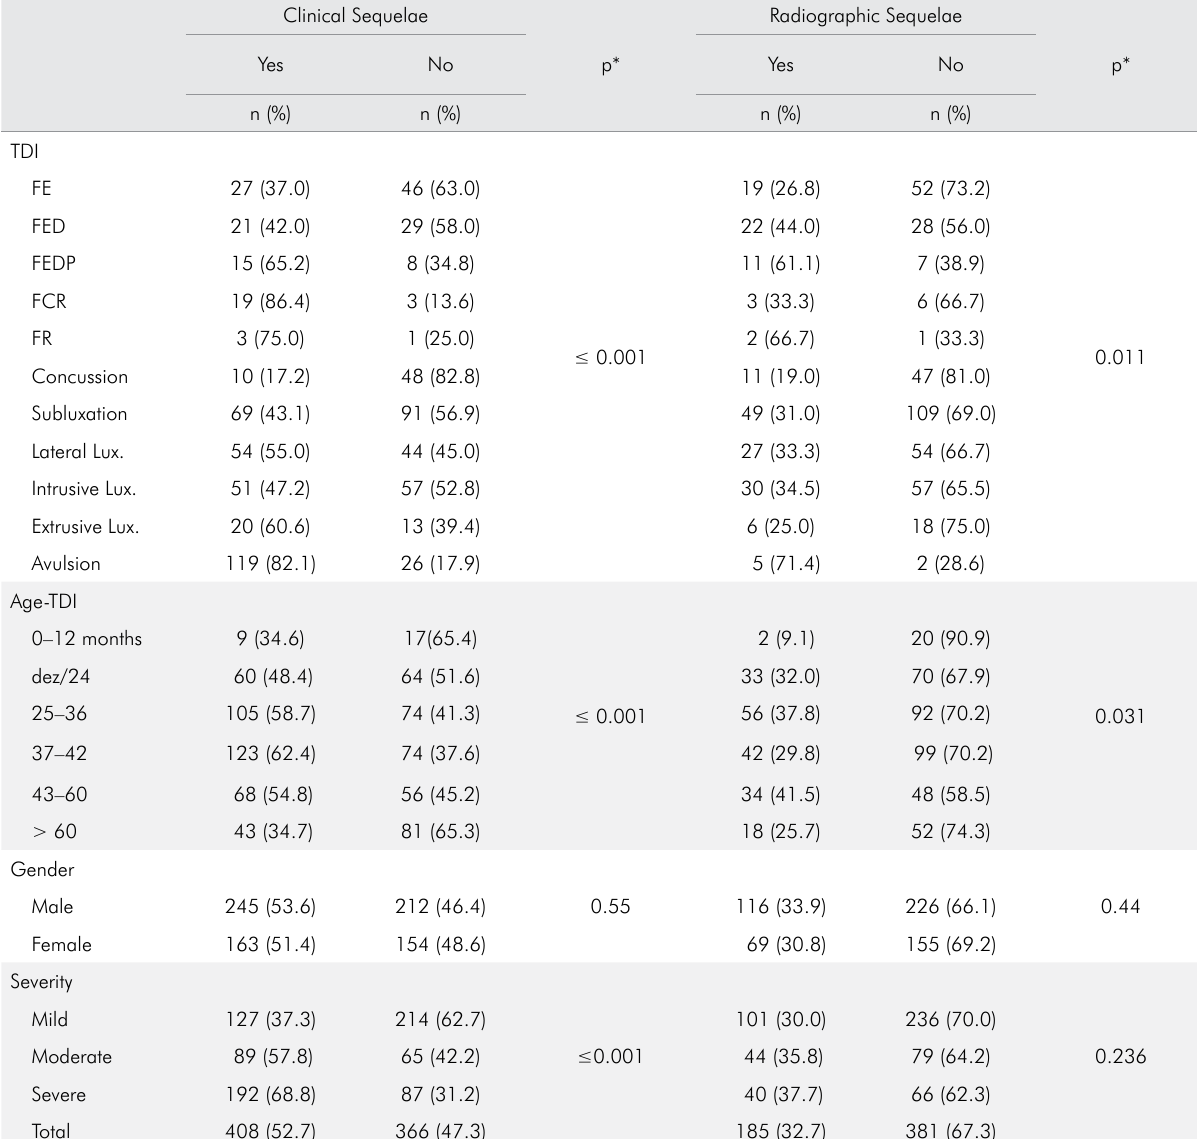
table 1. Presence of clinical and radiographic sequelae according to type of injury, child’s age at the time of TDI, and injury severity. (NETRAD). Pelotas, Brazil, 2015.